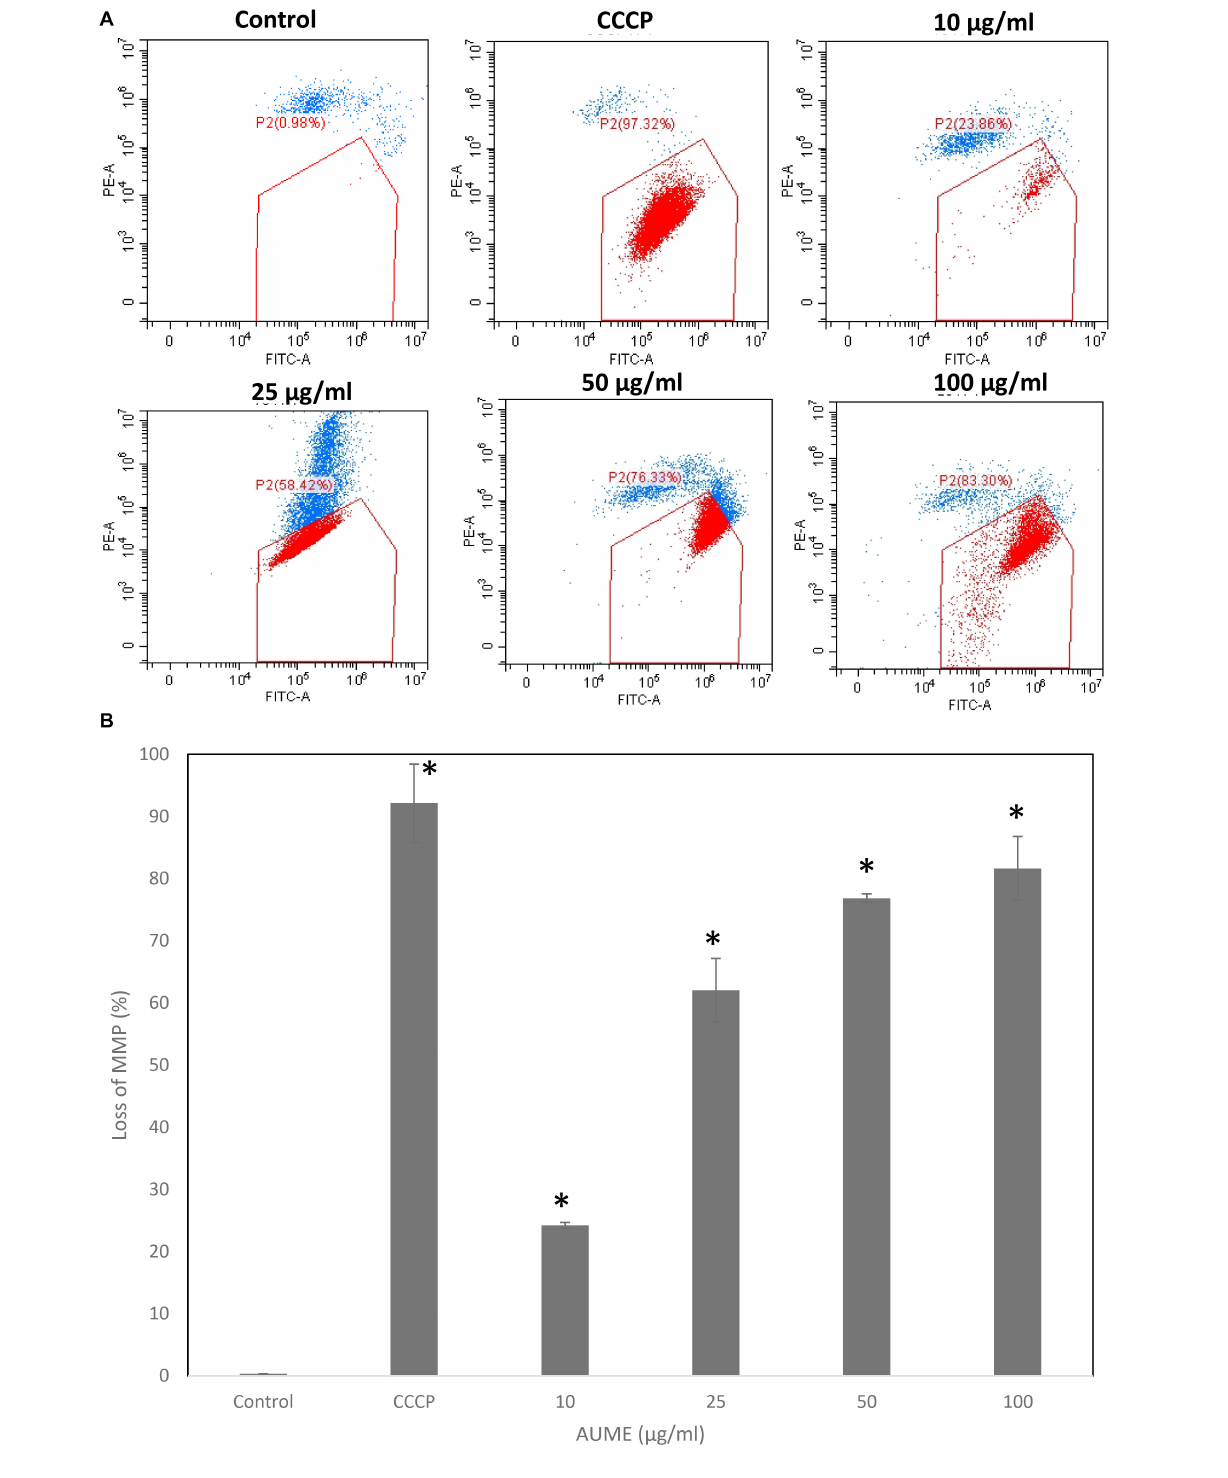
Frontiers in Marine Science |